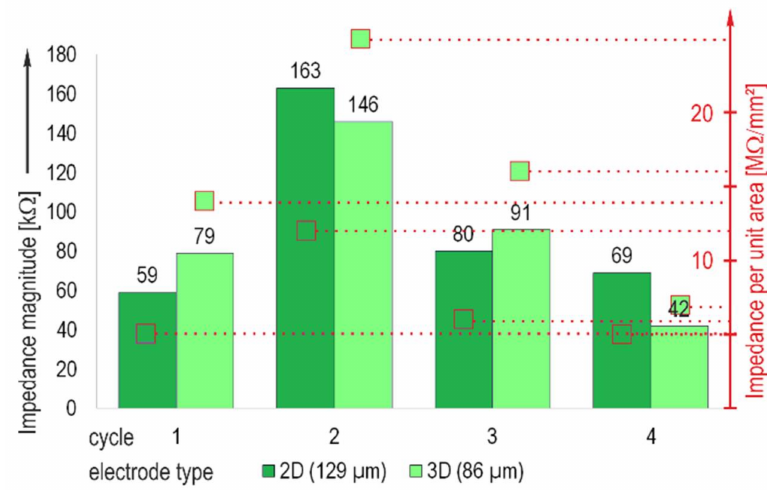
Figure 5. Median of the electrode impedance magnitude and impedance per unit area, measured at 1 kHz for the type C MEA, thick film gold with laminin coating.